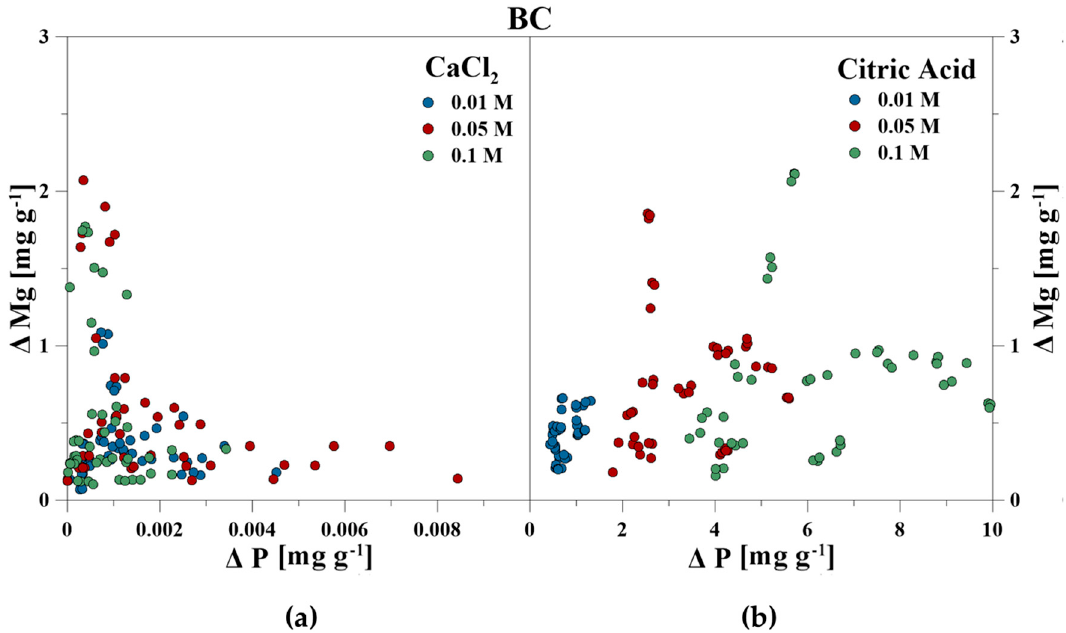
Figure 6. Correlation between dissolved P and Mg during P release using ( a ) CaCl 2 and ( b ) CA from bone char.